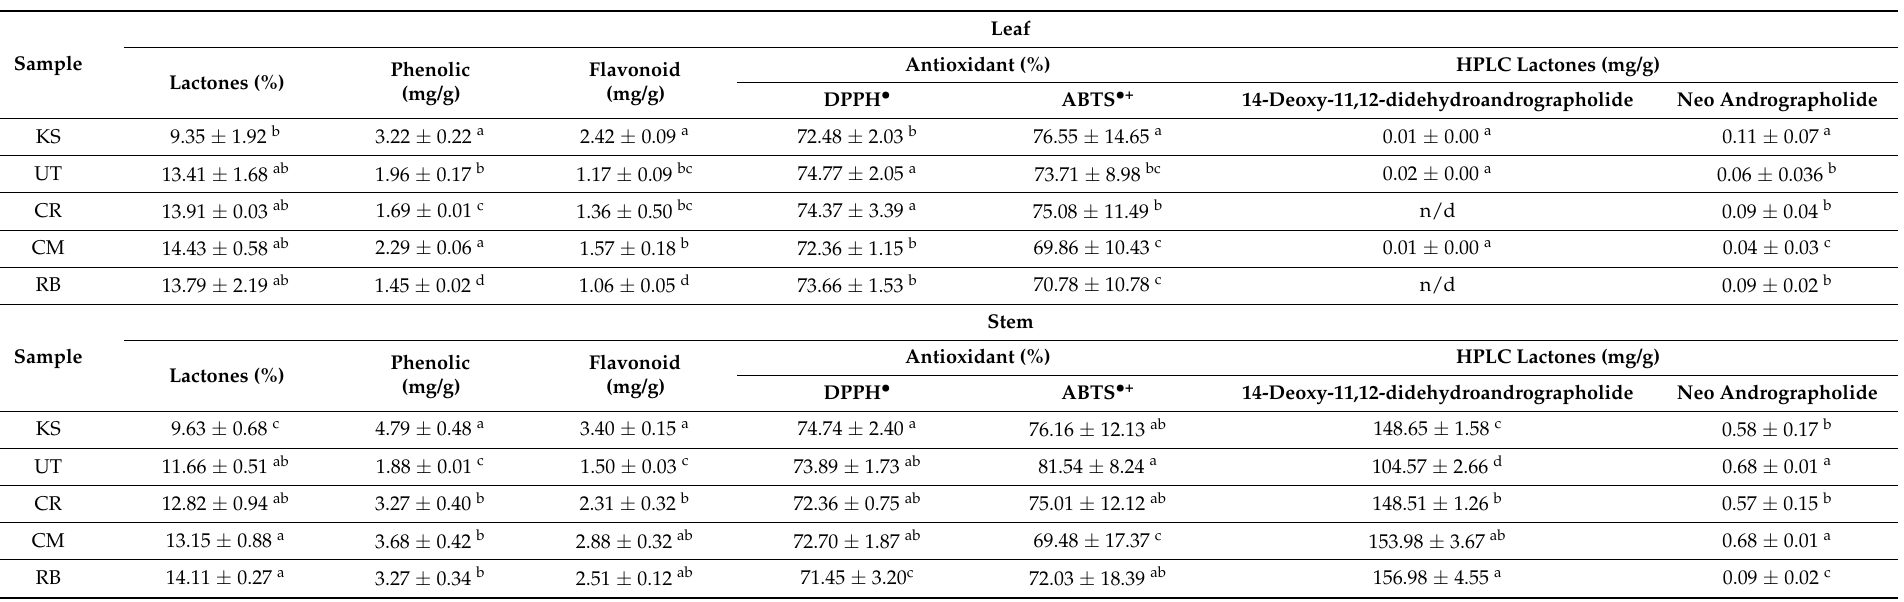
Table 2. Chemical properties of Andrographis paniculata